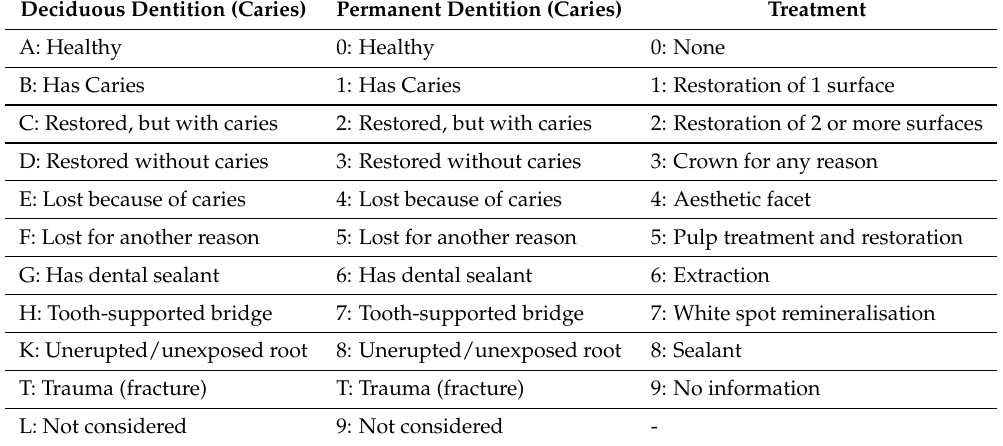
Table 2. Odontogram with two complementary structures – crown and treatment. Source: Author’s own